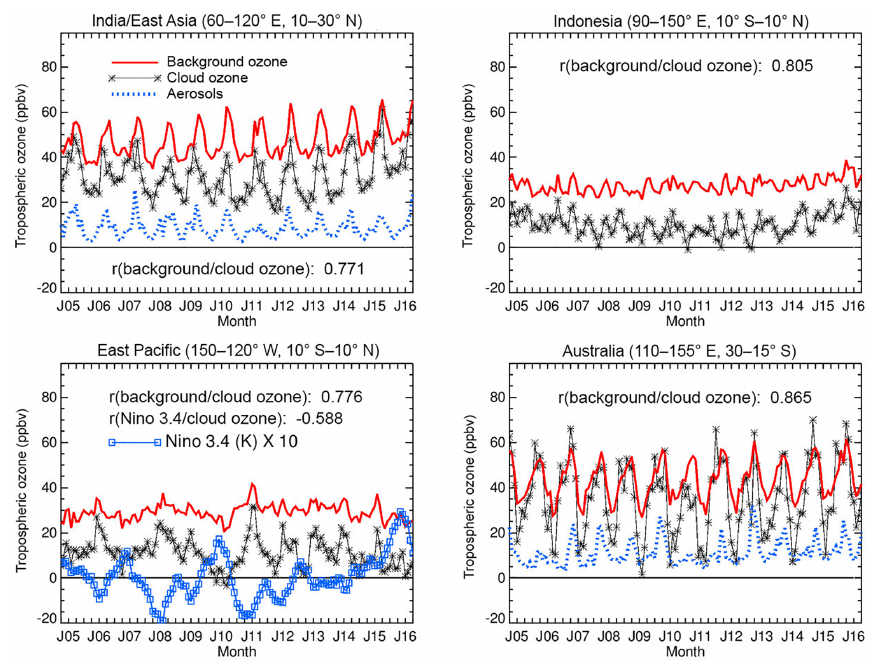
Figure 9. Similar to Fig. 8, but instead for the regions of India/east Asia, Indonesia, eastern Pacific, and Australia. Aerosol index time series (dotted) for the landmass regions is again shown. Also included for the eastern Pacific (lower left panel) is the Niño 3.4 index (blue squares, units K) and its correlation with cloud ozone. The Niño 3.4 index was rescaled (multiplied by 10) for plotting with ozone time